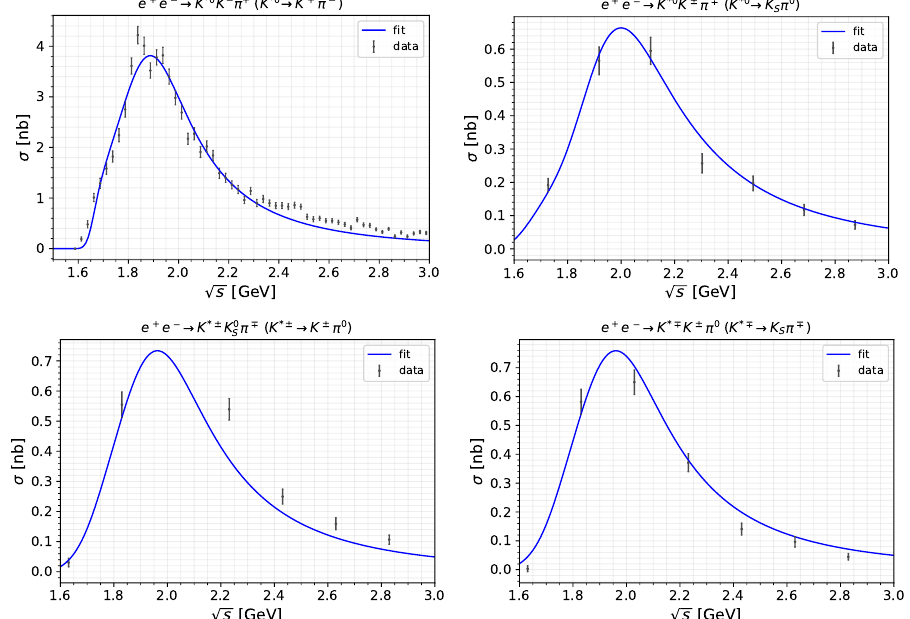
Figure 20 . Cross-section for the charged K ∗ 0 K ± π ∓ (upper left panel), neutral K ∗ 0 K ± π ∓ (upper right panel), K ∗± K ∓ (lower left panel) and K ∗∓ K ± π 0 (lower right panel) hadronic final states. S π The blue curve shows the best fit solution to the cross-section, obtained considering the fit values of table 5. The black points and error bars represent data from [90,